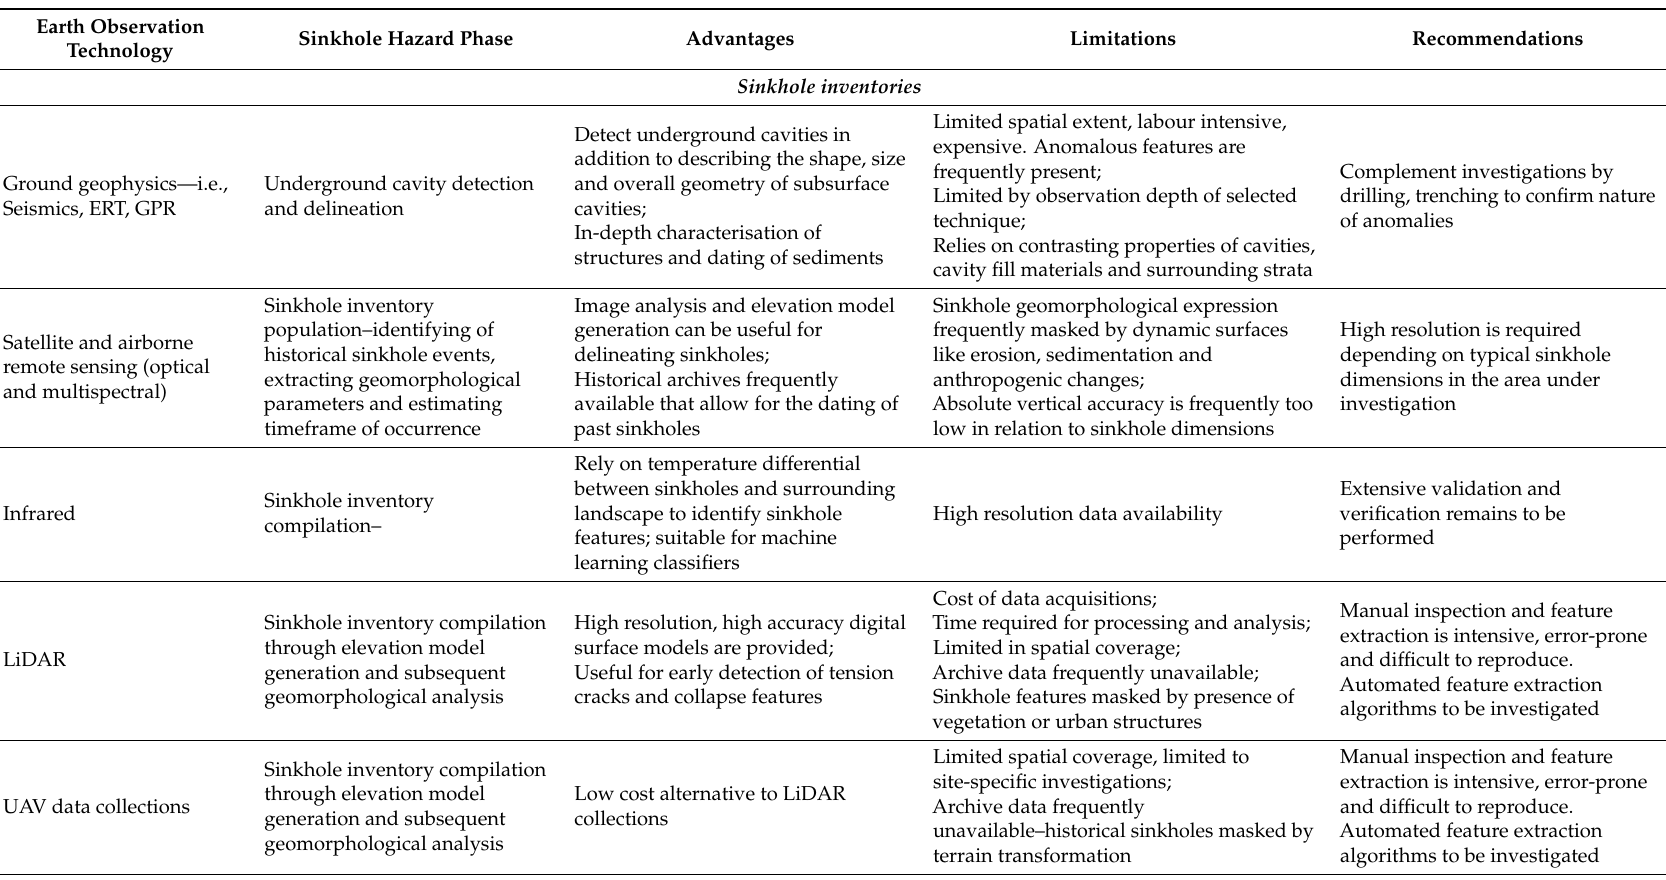
Table 2. The advantages and limitations of various earth observation technologies employed for the compilation of sinkhole inventories and the detection of sinkhole